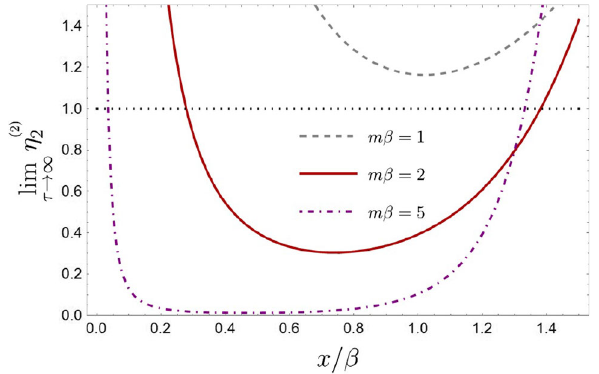
Fig. 10 Correlation function for the thermal contribution to the veloc- ities dispersions for D = 3. Here we set m β = 1. One can see that the correlation takes on negative values, so that the dispersions become bounded for large values of the interaction time with the relaxation time of the fluid, giving (cid:4) ((cid:10)v i ) 2 (cid:5) ∝ τ